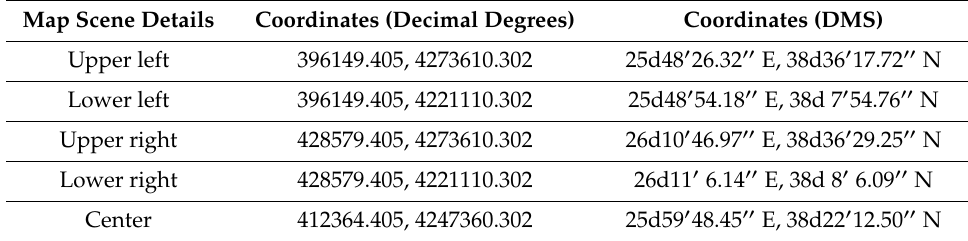
Table 2. Map extent of the scene and coordinates of the center.